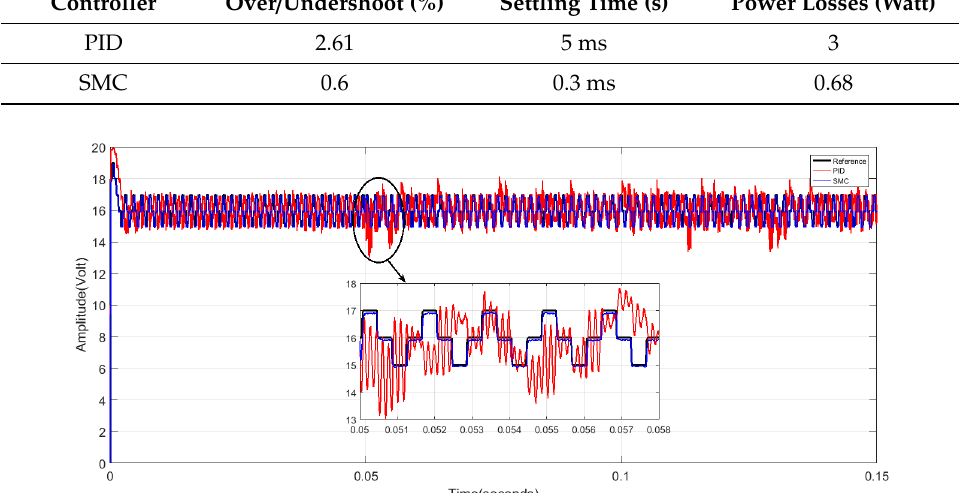
Table 3. Performance characteristics of the conventional PID and the proposed SMC controller.